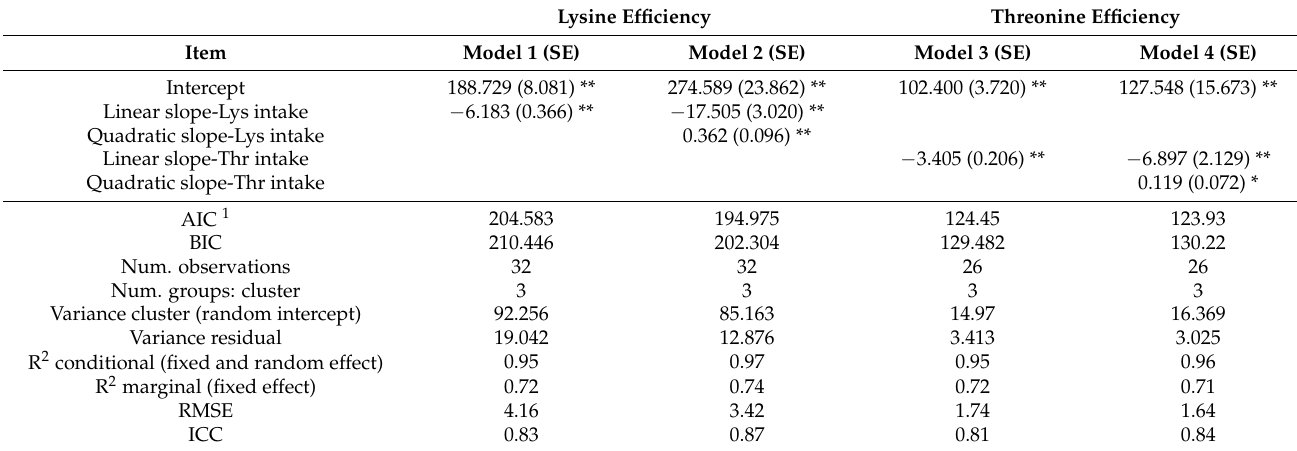
Table 5. Mixed model coefficients used to explore the variance in Lysine (Lys) and Threonine (Thr) efficiency of utilization above maintenance as a function of the amino acid intake using a Bayesian approach, where the protein deposition cluster was considered a random